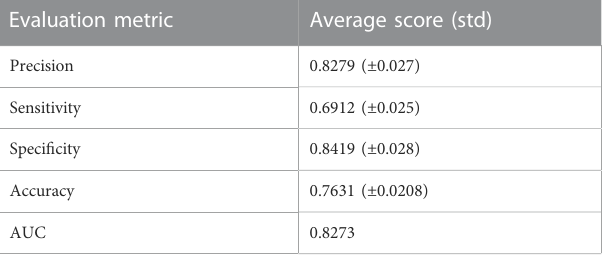
TABLE 4 Classi fi cation metrics for our